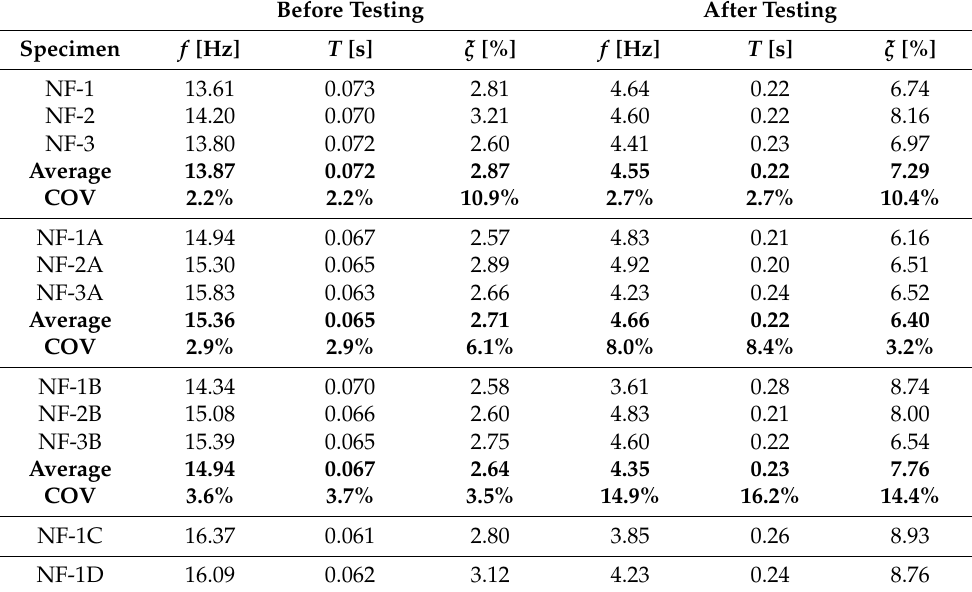
Table 4. Natural frequencies f , corresponding time period T , and damping ratios ξ of tested non- structural walls in the out-of-plane direction obtained with the forced vibration method. Before Testing After Testing